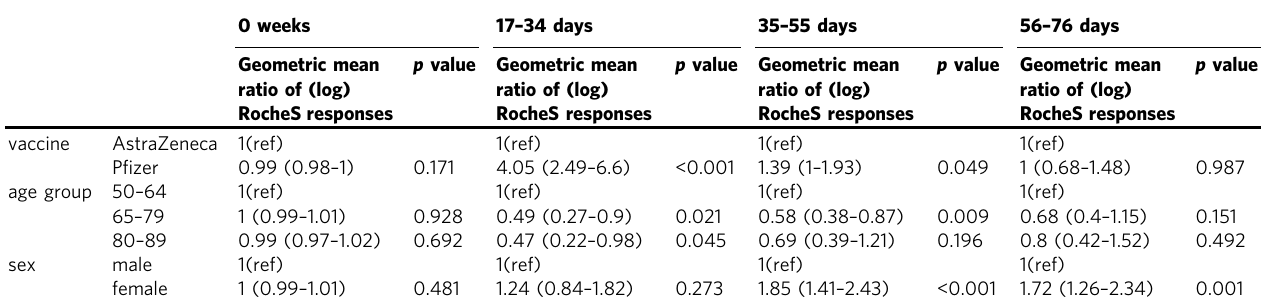
Fig. 1 Reverse cumulative distribution curves, antibody responses following the fi rst dose of COVID-19 vaccine in previously uninfected individuals, by the vaccine, age group and including a curve for unvaccinated convalescent cases 56 – 98 days post-infection. S-antibody levels at 17 – 34, 35 – 55 and 56 – 76 days after dose 1. Blue: AstraZeneca (AZ) recipients aged 50 – 64 years old; Red: Az recipients aged 65 – 79 years old; Green: P fi zer recipients aged 65 – 79 years old; Yellow: P fi zer recipients aged 80 – 89 years old; Light blue/grey: Post SARS-CoV-2 infection convalescent plasma. The green dashed line is the assay positive cut-off (0.8). Table 2 Geometric mean ratio (GMR) of responses, adjusted for age and sex, following dose 1 of an extended vaccine schedule. P values relate to two-sided z -tests of log(GMR) =